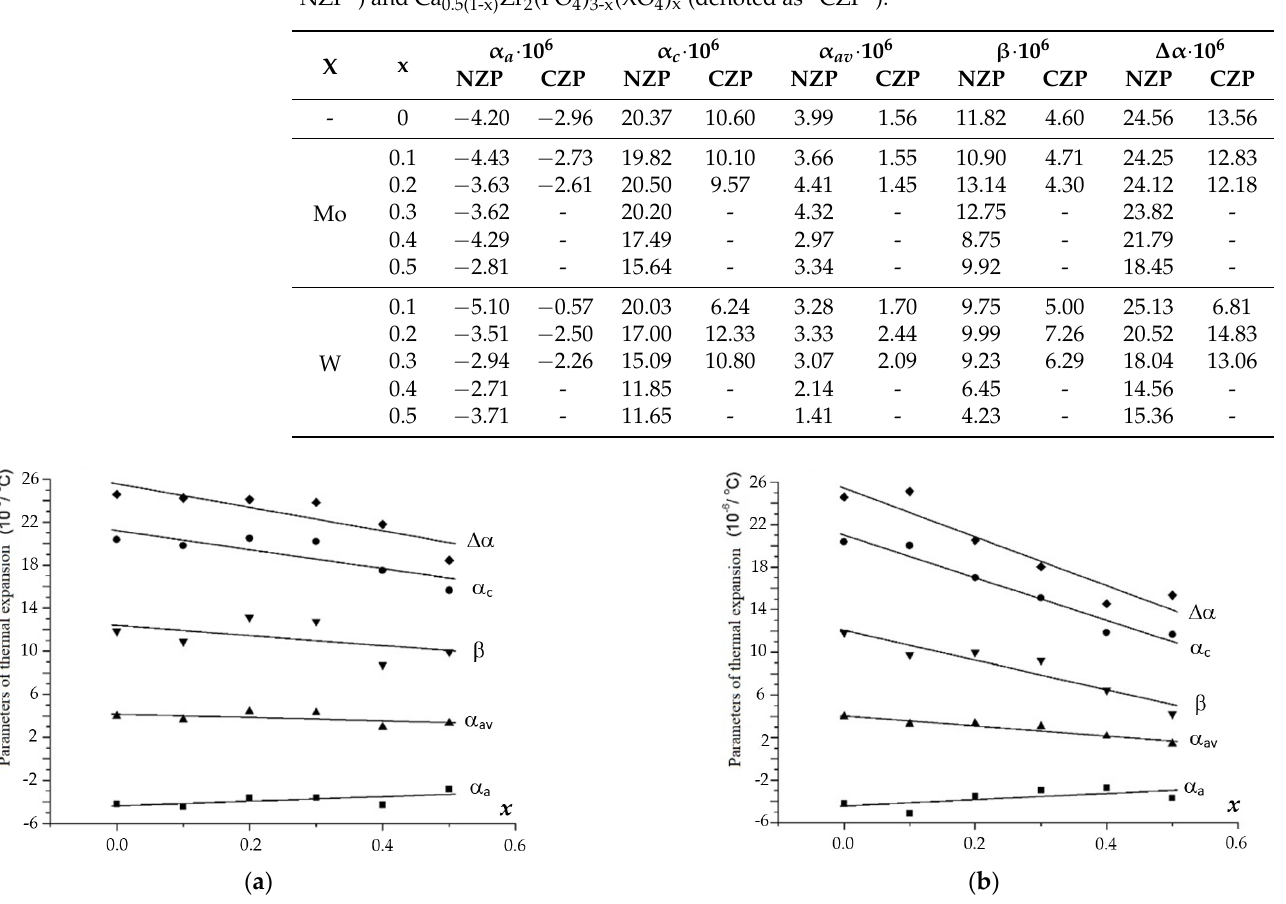
Table 2. Thermal expansion coefficients [in ◦ C − 1 ] of phosphates Na 1-x Zr 2 (PO 4 ) 3-x (XO 4 ) x (denoted as